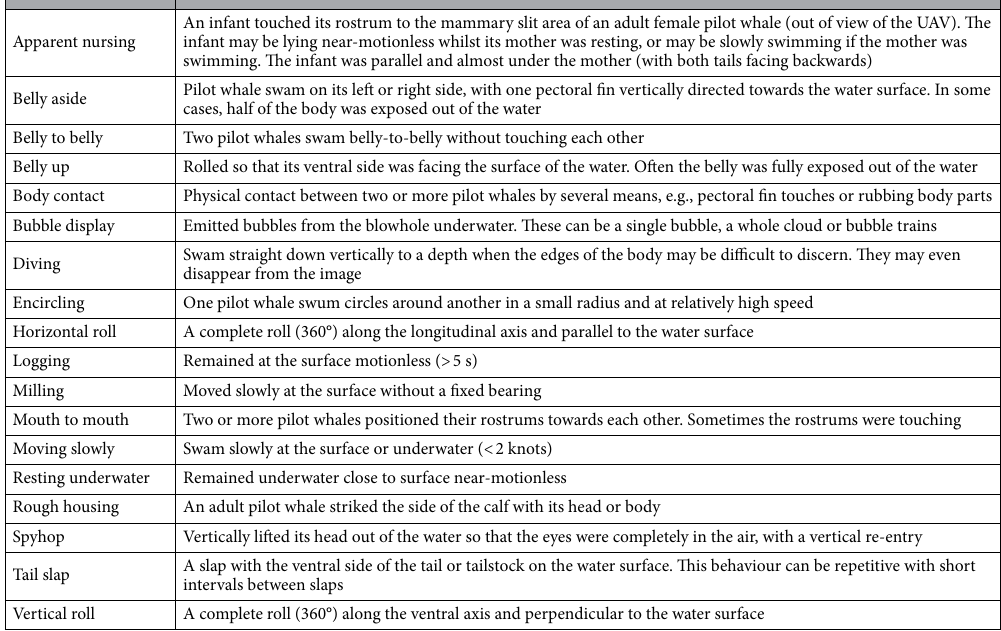
Table 1. Behavioural events of pilot whales for Tenerife, based on 49 .